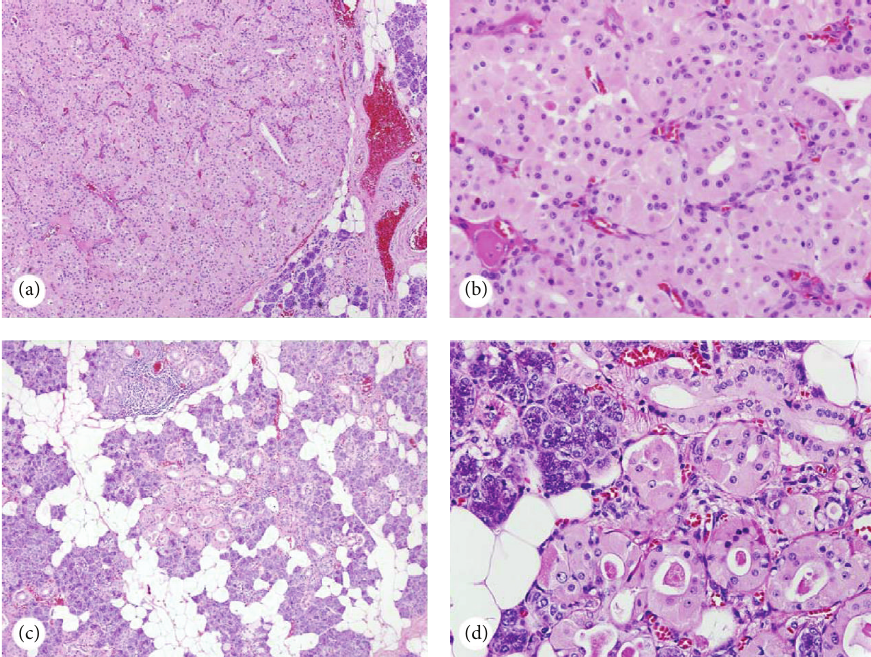
Figure 2: Histology of the submandibular oncocytoma. (a-b) The tumor is well circumscribed with a thin capsule ((a) × 100) and is composed of benign appearing oncocytes ((b) × 400); (c)-(d) foci of oncocytes present at the tumor adjacent submandibular tissue ((c) × 100; (d) ×